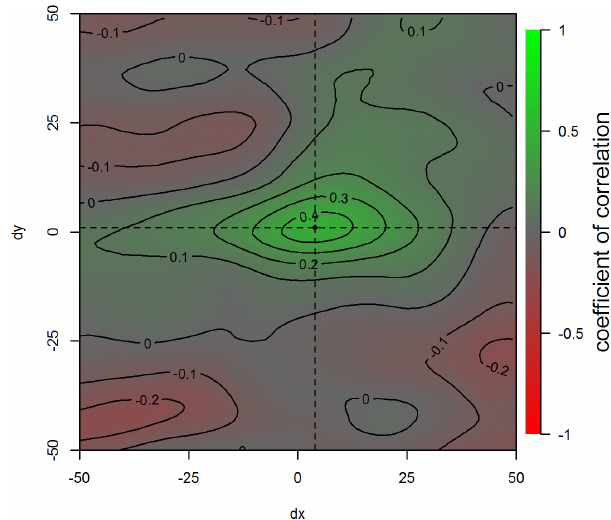
Figure 4. Coefficient of correlation for the LST time series data. The mean coefficient of correlation for all 756 combinations shows a centered behavior (single peak area with maximum correlation of 0.47; green) with a low shift (4,1) within a maximum range of [− 50 , + 50 ] in both x and y direction. The size of the correlation window is 51 × 51px for 5 fixed, non-overlapping positions ( throughout the